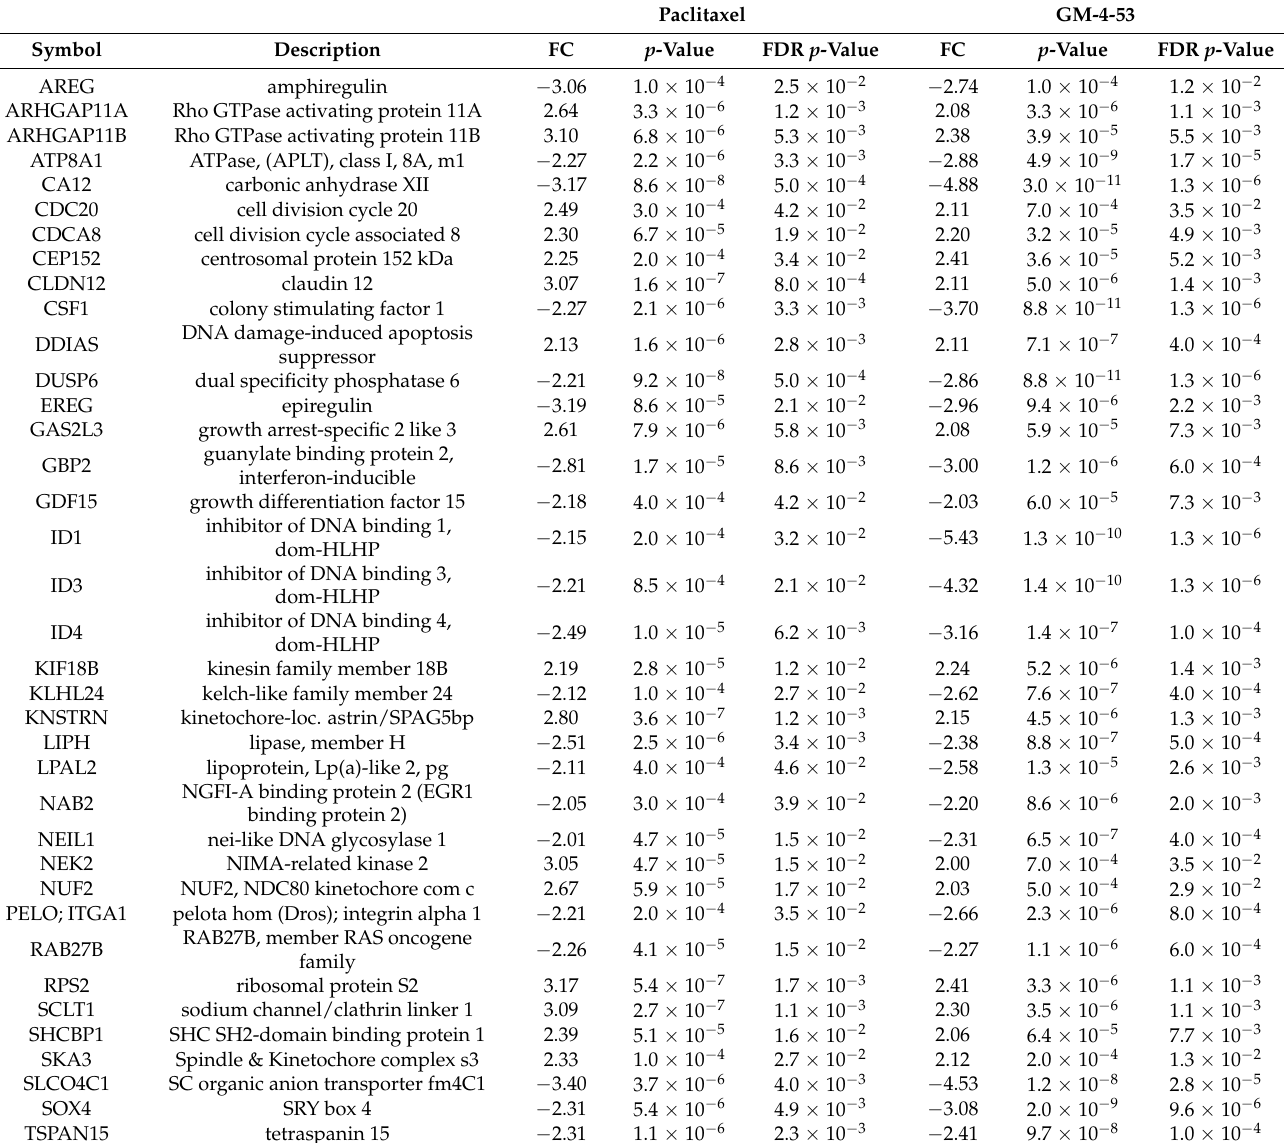
Table 2. Overlapping DEG profiles between GM-4-53 and paclitaxel. The data represent fold change for genes meeting the selection criteria = FC > 2 or < − 2, p -value < 0.05, and FDR p -value <